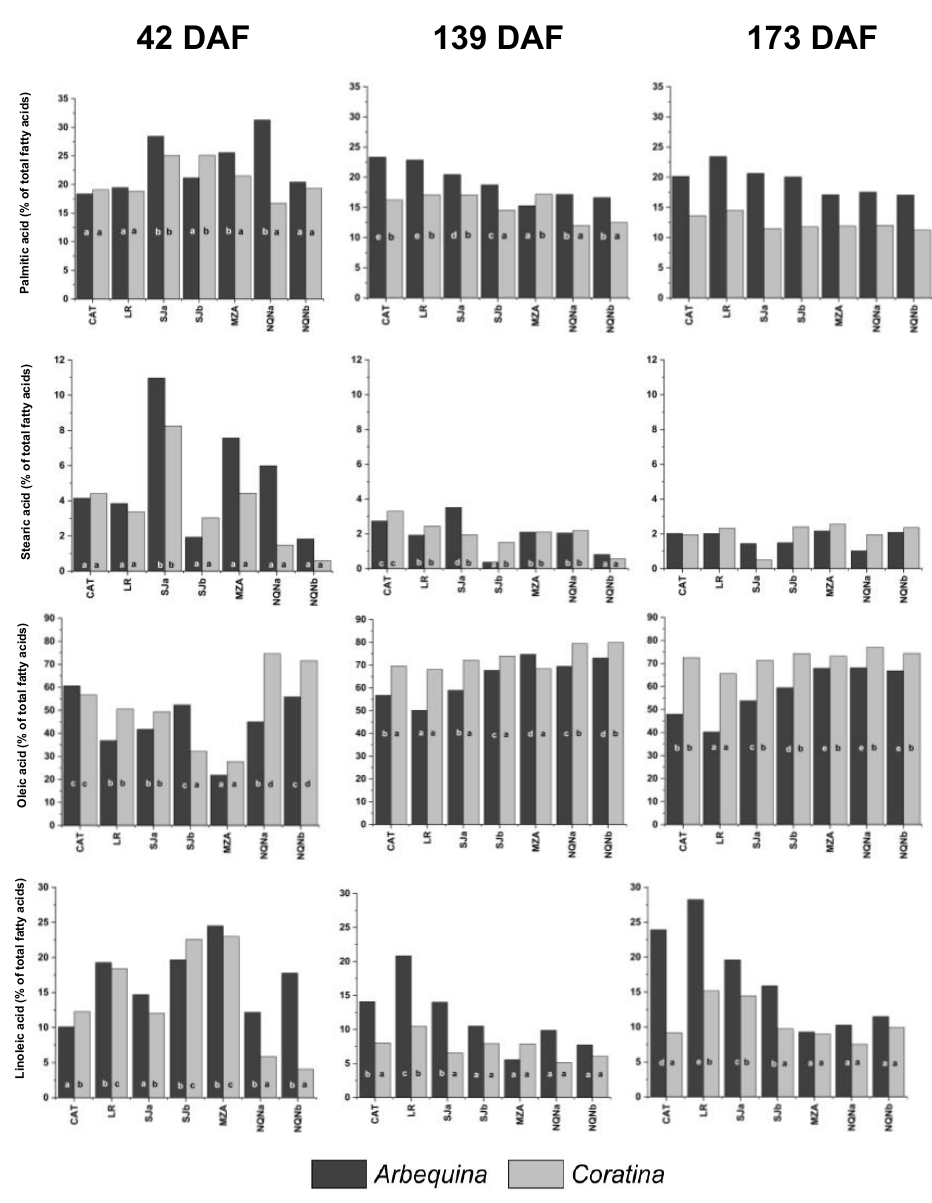
Figure 2. Percentage of main fatty acids (palmitic, stearic, oleic and linoleic acids) during three fruit phenological stages (42, 139 and 173 days after full flowering (DAF)) in cvs. Arbequina and Coratina in the seven analyzed growing environments (Catamarca (CAT), 2014/15; La Rioja (LR), 2015/16; San Juan (SJa), 2014/15; San Juan (SJb), 2015/16; Mendoza (MZA) 2015/16; Neuquén (NQNa) 2014/15; and Neuquén (NQNb), 2015/16). Different letters correspond to significant differences at p < 0.05 among environments for a given phenological stage.